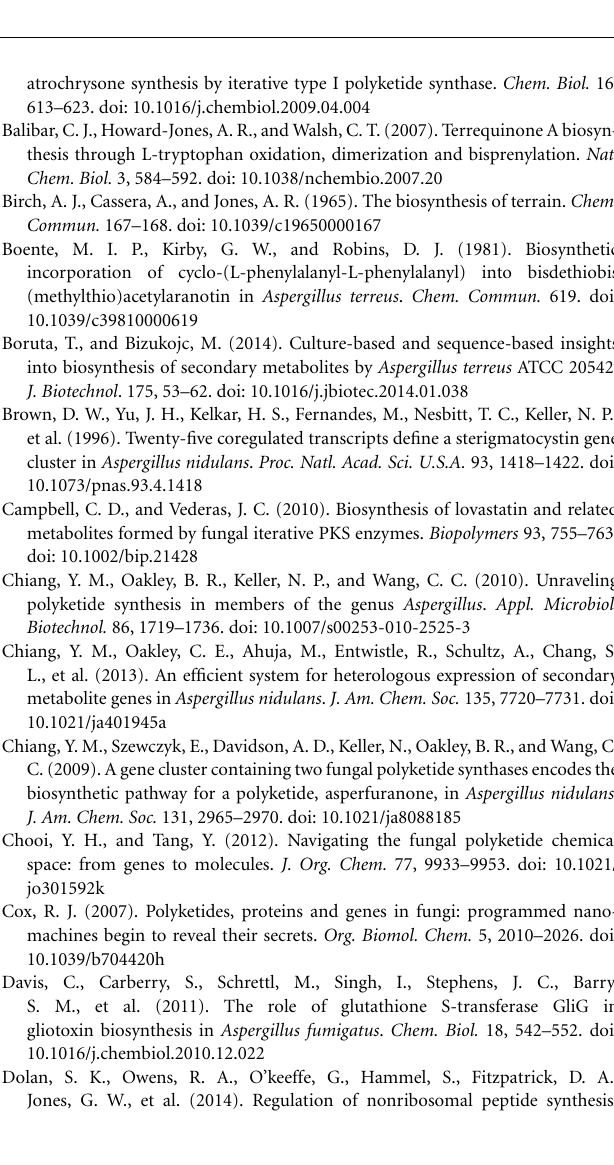
FIGURE 9 | Biosynthesis of flavipucine in A. terreus